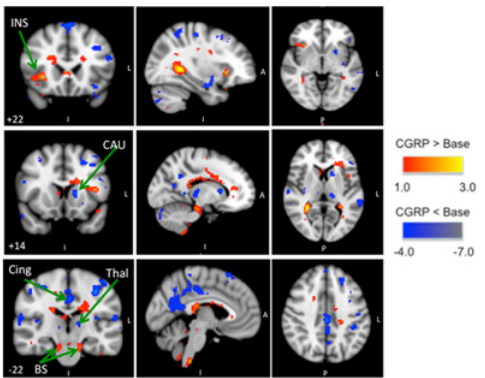
Fig 7. BOLD-signal during CGRP infusion: Group BOLD-fMRI results for noxious heat simulations to the V1 area on the CGRP day; differences between neuronal activation at T 40 (after CGRP infusion) and T -5 (baseline). The activated regions-of-interest are shown in three projections. CGRP infusion resulted in positive activation in insula and bilateral activation in the brainstem, while negative activation was recorded in the caudate nuclei, thalamus and cingulate